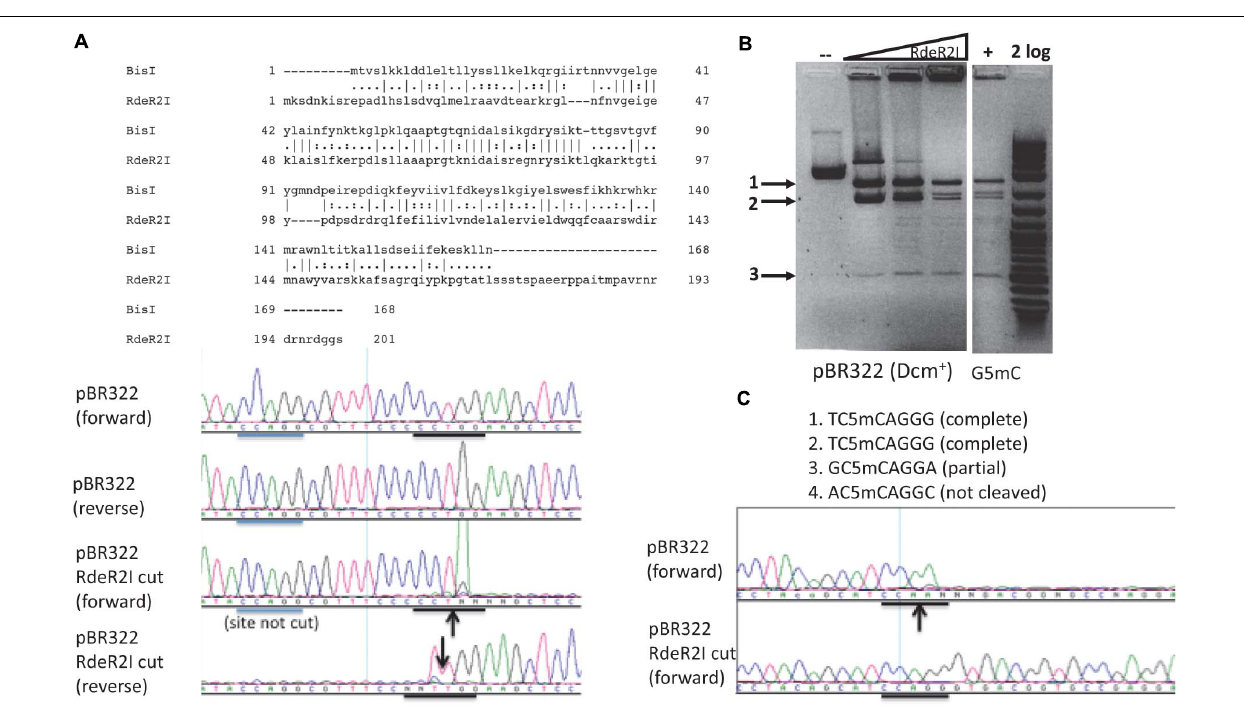
FIGURE 6 | Pairwise sequence alignment between RdeR2I and BisI, RdeR2I activity assay on pBR322 and mapping of cleavage sites. (A) Pairwise sequence alignment between RdeR2I and BisI. RdeR2I has an additional 33 residues at the C-terminus. (B) RdeR2I activity assay on pBR322 (Dcm + ) or M.CviPI-modified pBR322 (Gm5C). (C) Mapping of the cleavage sites by DNA sequencing indicated that two sites were completely digested (TCCAGGG). The down arrow indicates the strand shown is cleaved (with an extra T peak). The up arrow indicates the opposite strand is cleaved (with the appearance of an extra A peak). Arrows in (B) indicate the digested fragments from pBR322, which correspond to the sites shown in (C)